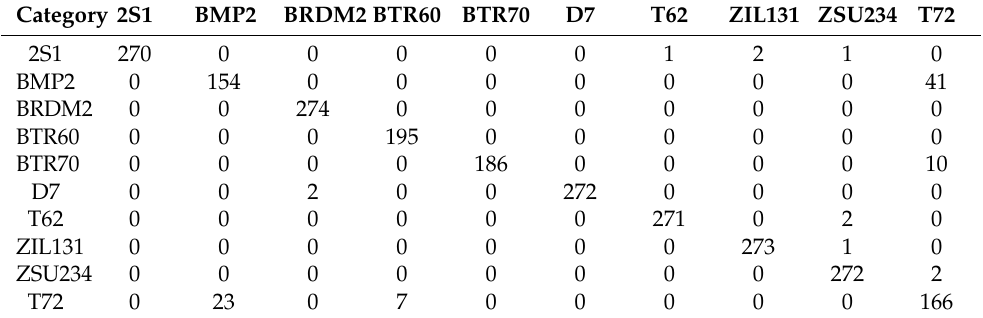
Table 6. T72 confusion matrix.